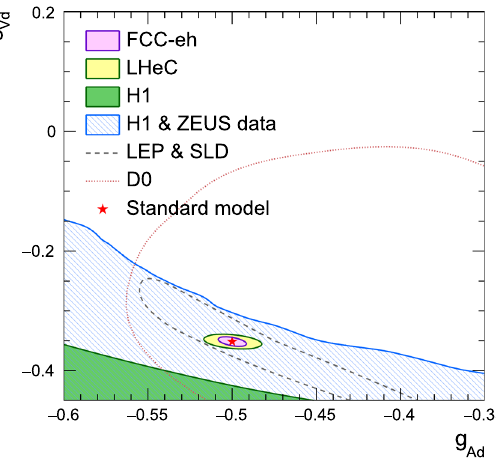
Fig. 3.6 The expected uncertainties for the light-quark weak neutral couplings ( g Au , g Ad , g Vu , g Vd ) from FCC-eh inclusive DIS data com- pared with the Standard Model expectations and the currently most precise measurements [32,56,57,66]. At the displayed scale, the con-